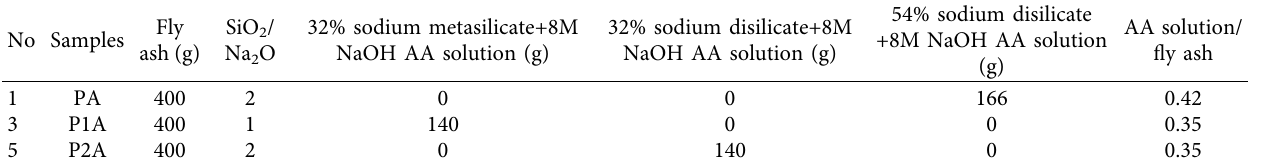
Table 2: Mix proportion of and detail of each type of paste.